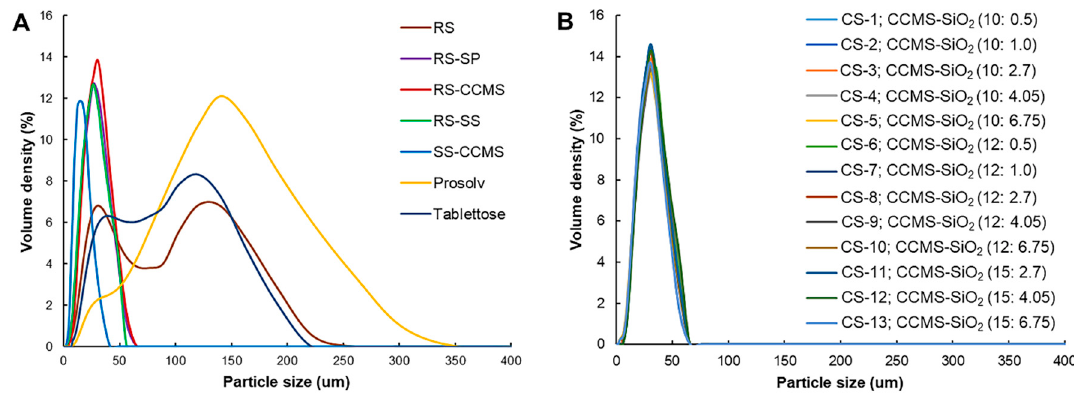
Figure 5. Particle size distribution curves of ( A ) RS, RS - SP, RS - CCMS, RS - SS, SS - CCMS, and commercial DC excipients, and ( B ) CSs with different CCMS (10%, 12%, 15%) and SiO 2 (0.5%, 1.0%, 2.7%, 4.05%, 6.75%) levels.